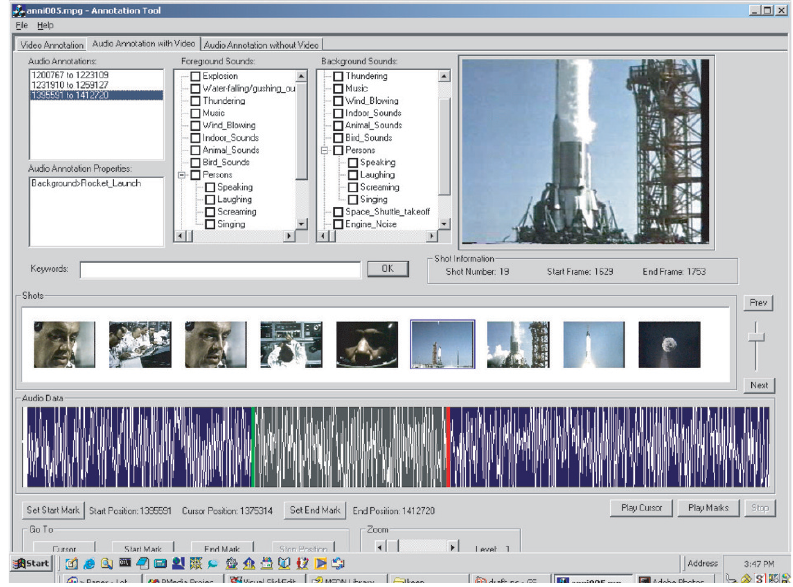
Figure 2: A multimodal annotation